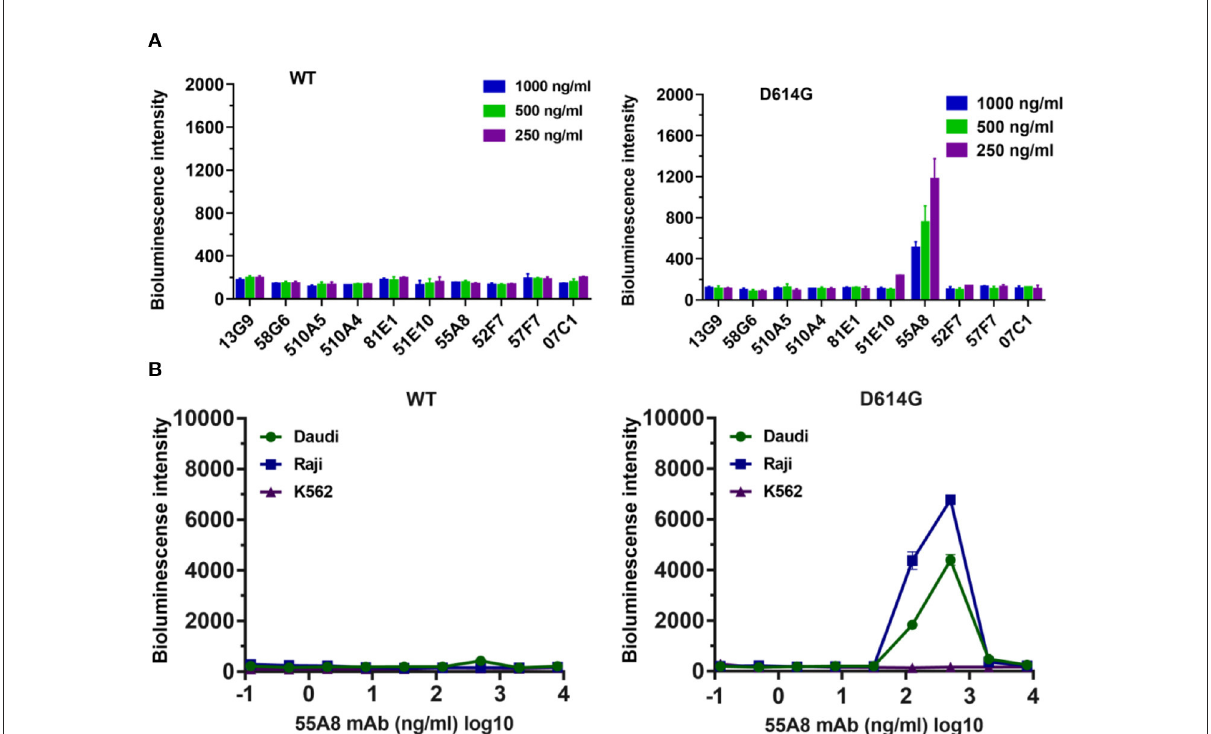
FIGURE2 Identification of the neutralizing antibodies (Nabs)-mediated enhancement of SARS-CoV-2 variant infection. (A) Assessment of the ADE activities of 10 potent NAbs against SARS-CoV-2 WT and the D614G variant. Pseudoviruses were preincubated with 250, 500, and 1,000ng/ml of NAbs, and these mixtures were added to Daudi cells to evaluate their ability to enhance infection. (B) Assessment of ADE activities of the neutralizing antibody 55A8 for SARS-CoV-2 WT and the D614G variant. Pseudoviruses preincubated with serial dilutions of 55A8 mixtures were added to Daudi, Raji, and K562 cells to evaluate their ability to enhance infection. RLU values resulting from infection with variant pseudotyped viruses were quantified by a luminescence meter. Data for each NAb were obtained from a representative infectivity experiment of three replicates and presented as the mean values ±